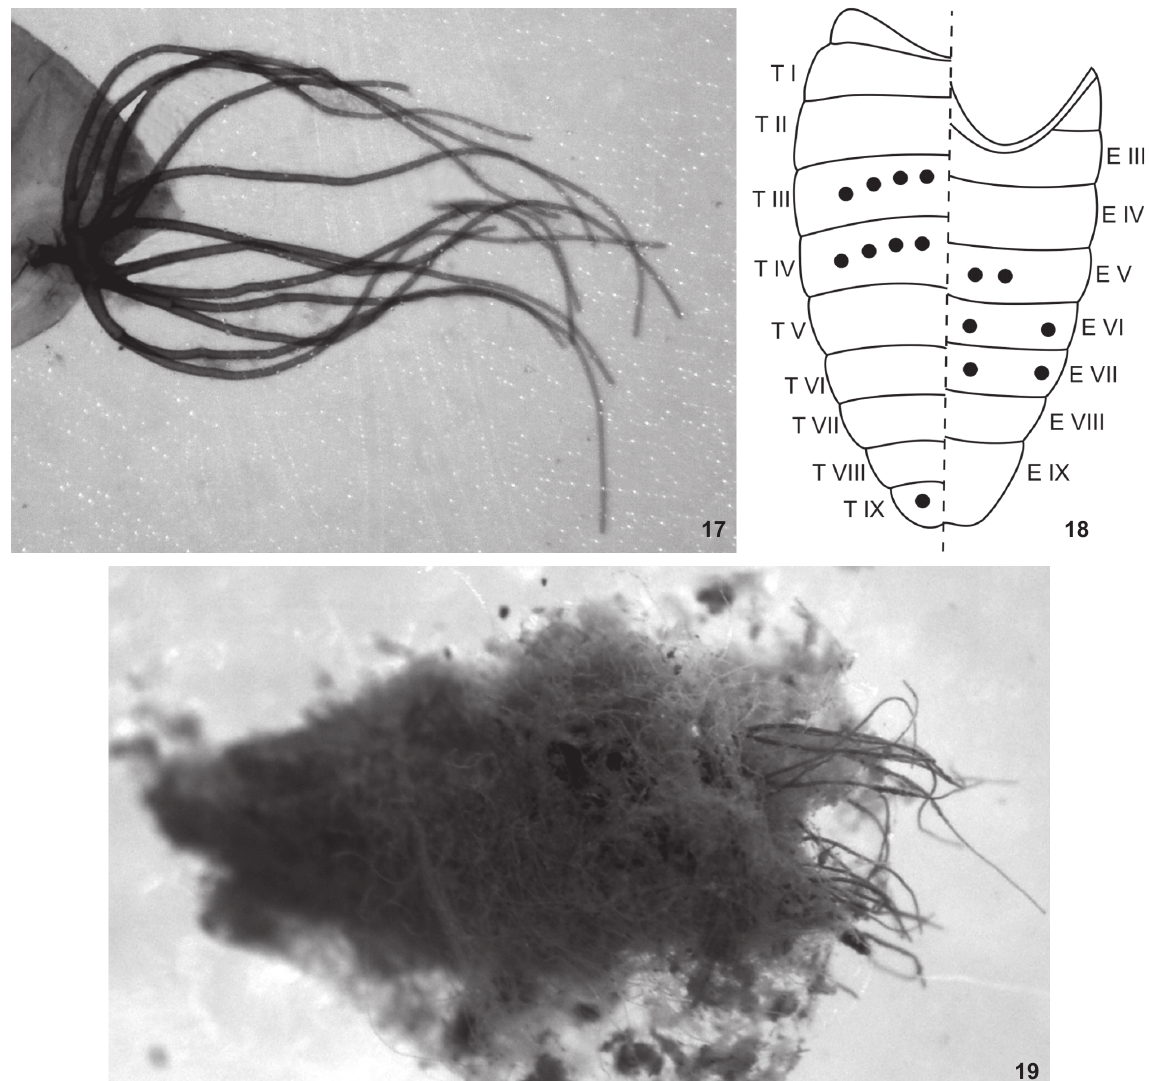
Figure 17-19. Pupa of L. flavopubescens : (17) gill; (18) abdominal chaetotaxy (round black dots represent hooks distribution); (19) pupa and